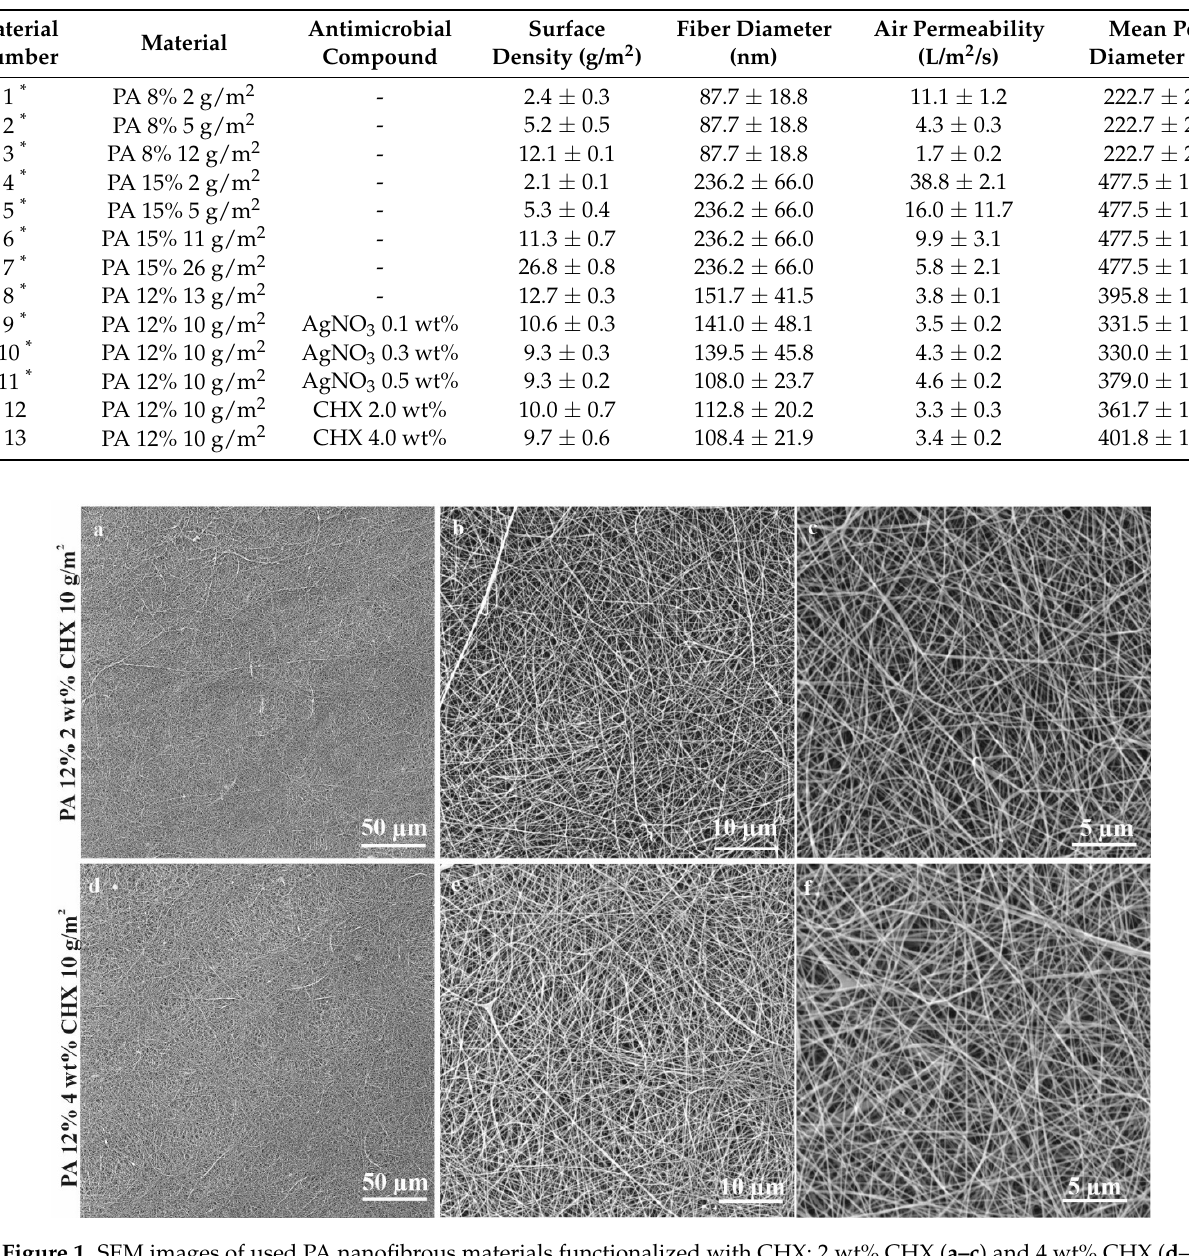
Figure 1. SEM images of used PA nanofibrous materials functionalized with CHX: 2 wt% CHX ( a–c ) and 4 wt% CHX ( d – f ) taken at magnifications of 1000× ( a , d ), 5000× ( b , e ), and 10,000× ( c , f ).